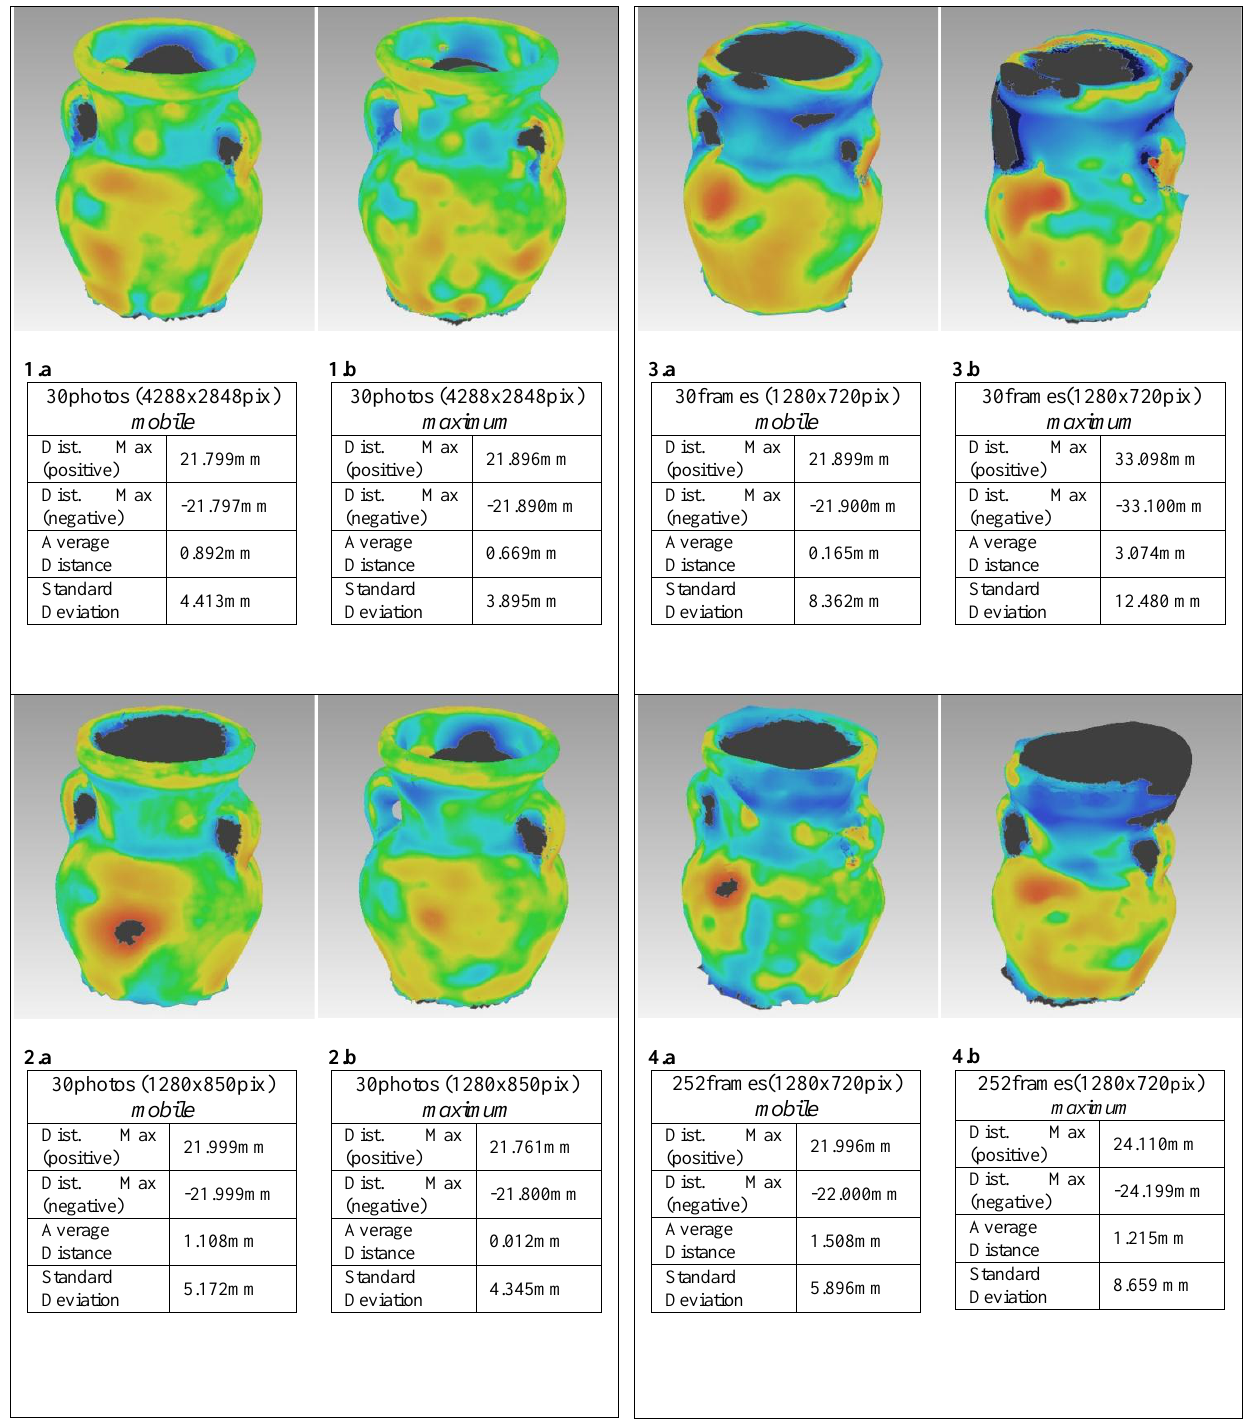
Table 1. Graphical representation of the values of the deviation according chromatic scale and relative value table of maximum distance (positive and negative), average distance, standard